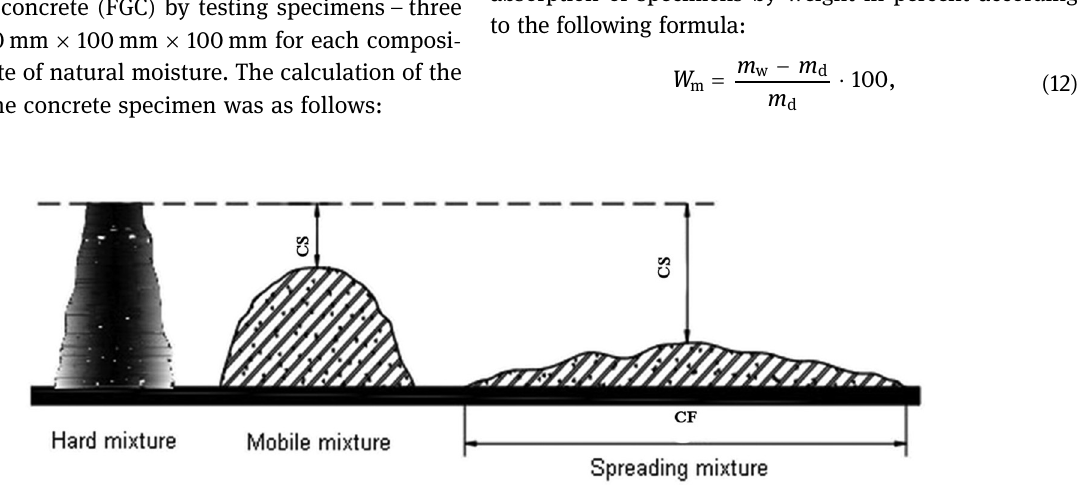
Figure 1: Determination of the workability of a concrete mixture by a slump cone.